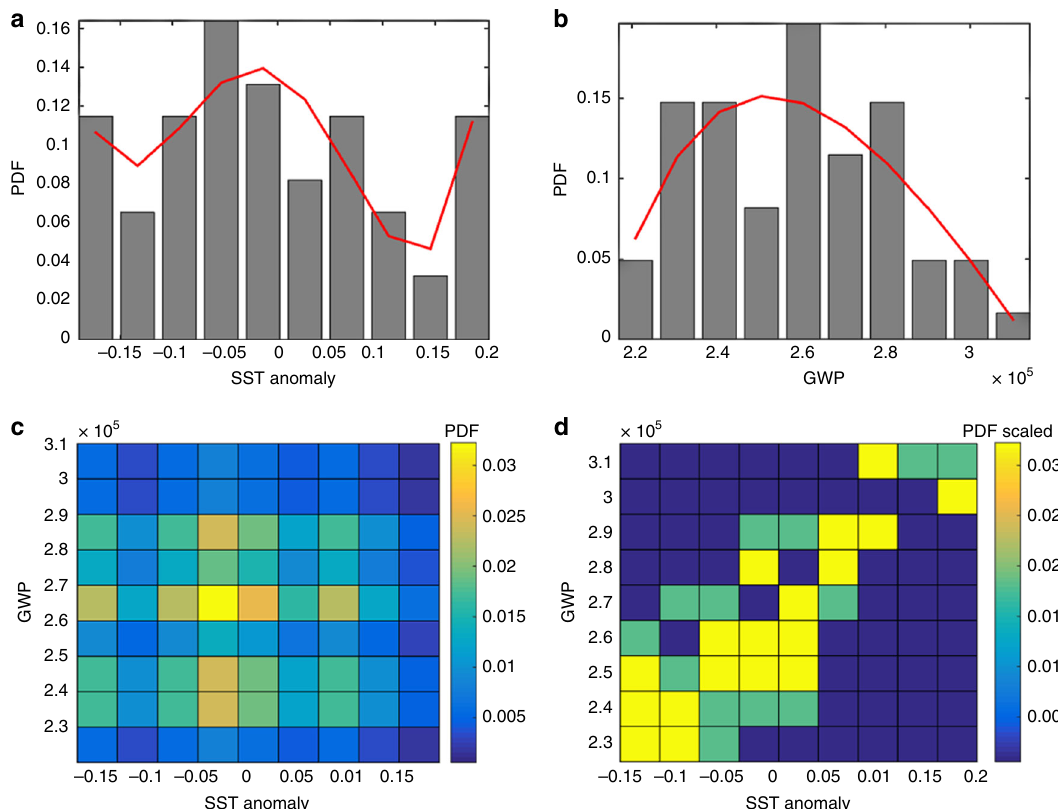
Fig. 4 Analysis of the statistical dependency of Global Wave Power on the Sea Surface Temperature anomaly. Probability density functions (PDFs) of a Sea Surface Temperature (SST) anomaly and b Global Wave Power (GWP); c the product of their marginal distributions; and d their joint distribution (scaled to the values in c ). The bar plots in a and b represent the empirical PDF, while the red lines represent a PDF fi tted to the data